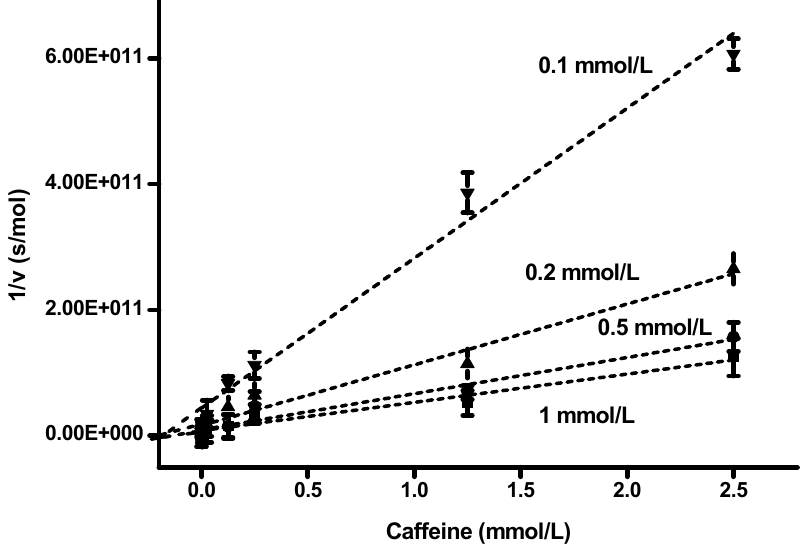
Figure 2. Dixon plot for human acetylcholinesterase (AChE). The concentration of the substrate is indicated beside each line. The data are extrapolated to cross the X-axis. Error bars reflect a standard deviation for n = 4.